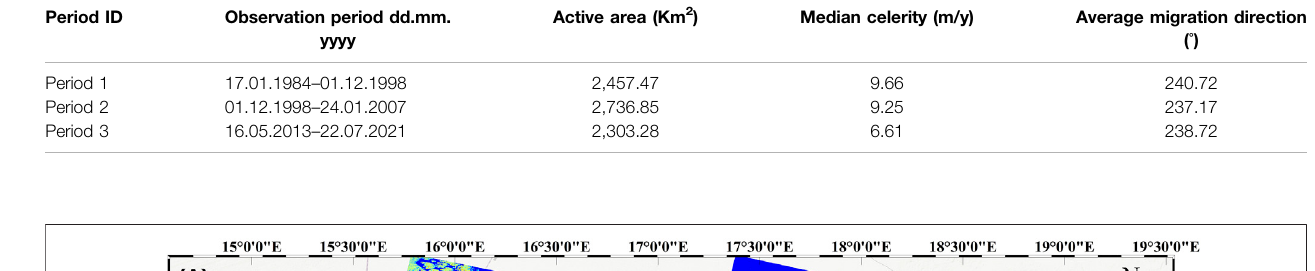
Table S15 . Owing to the fl exible inversion procedure, the spatial coverage of the different inversion networks reached 100%, with a lower limit of 98%.